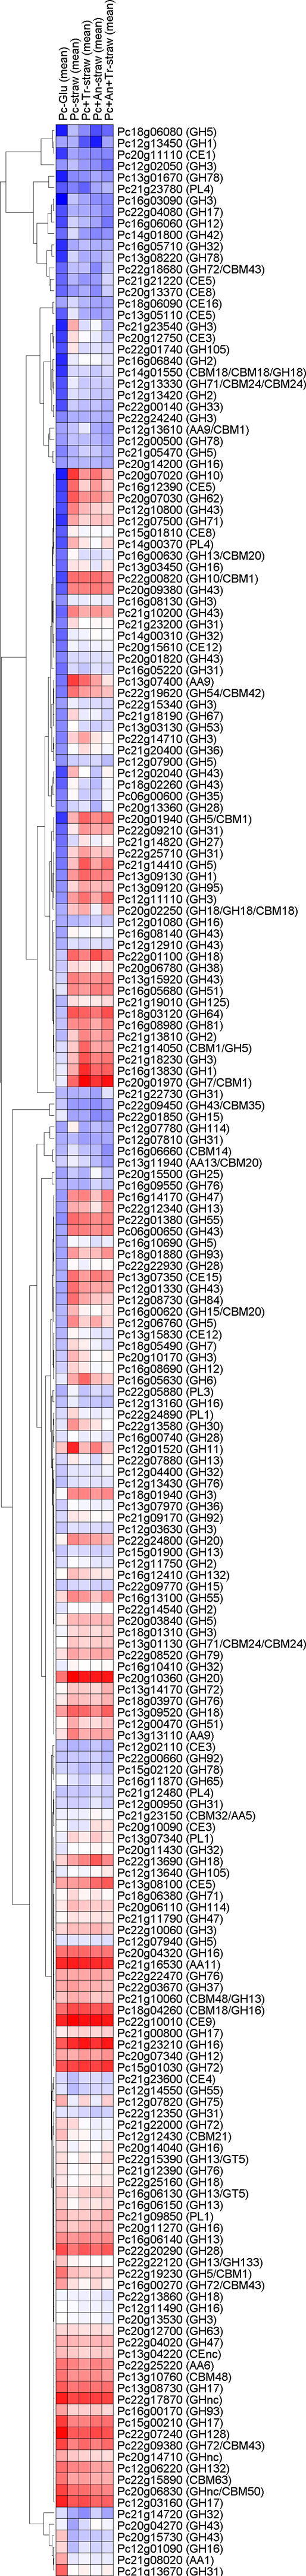
High resolution image of the hierarchical clustering of the P. chrysogenum CAZy genes from Fig.7(A).